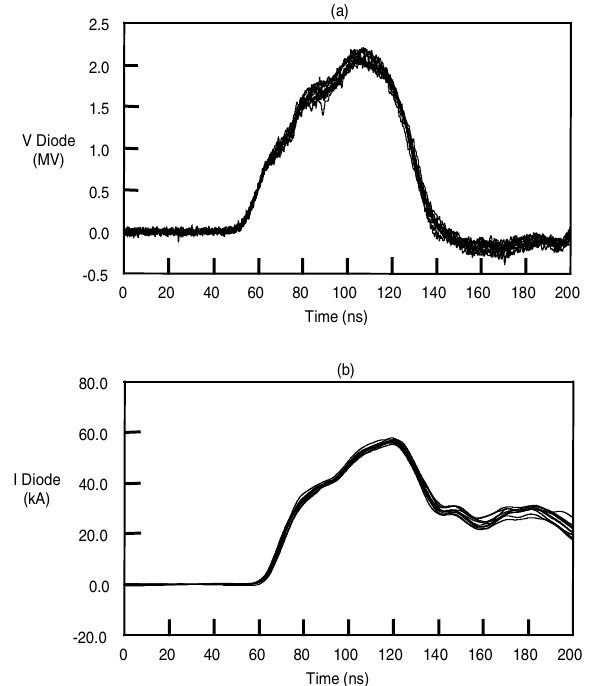
FIG. 38. Ten shot overlay of Cygnus diode (a) voltage and (b)